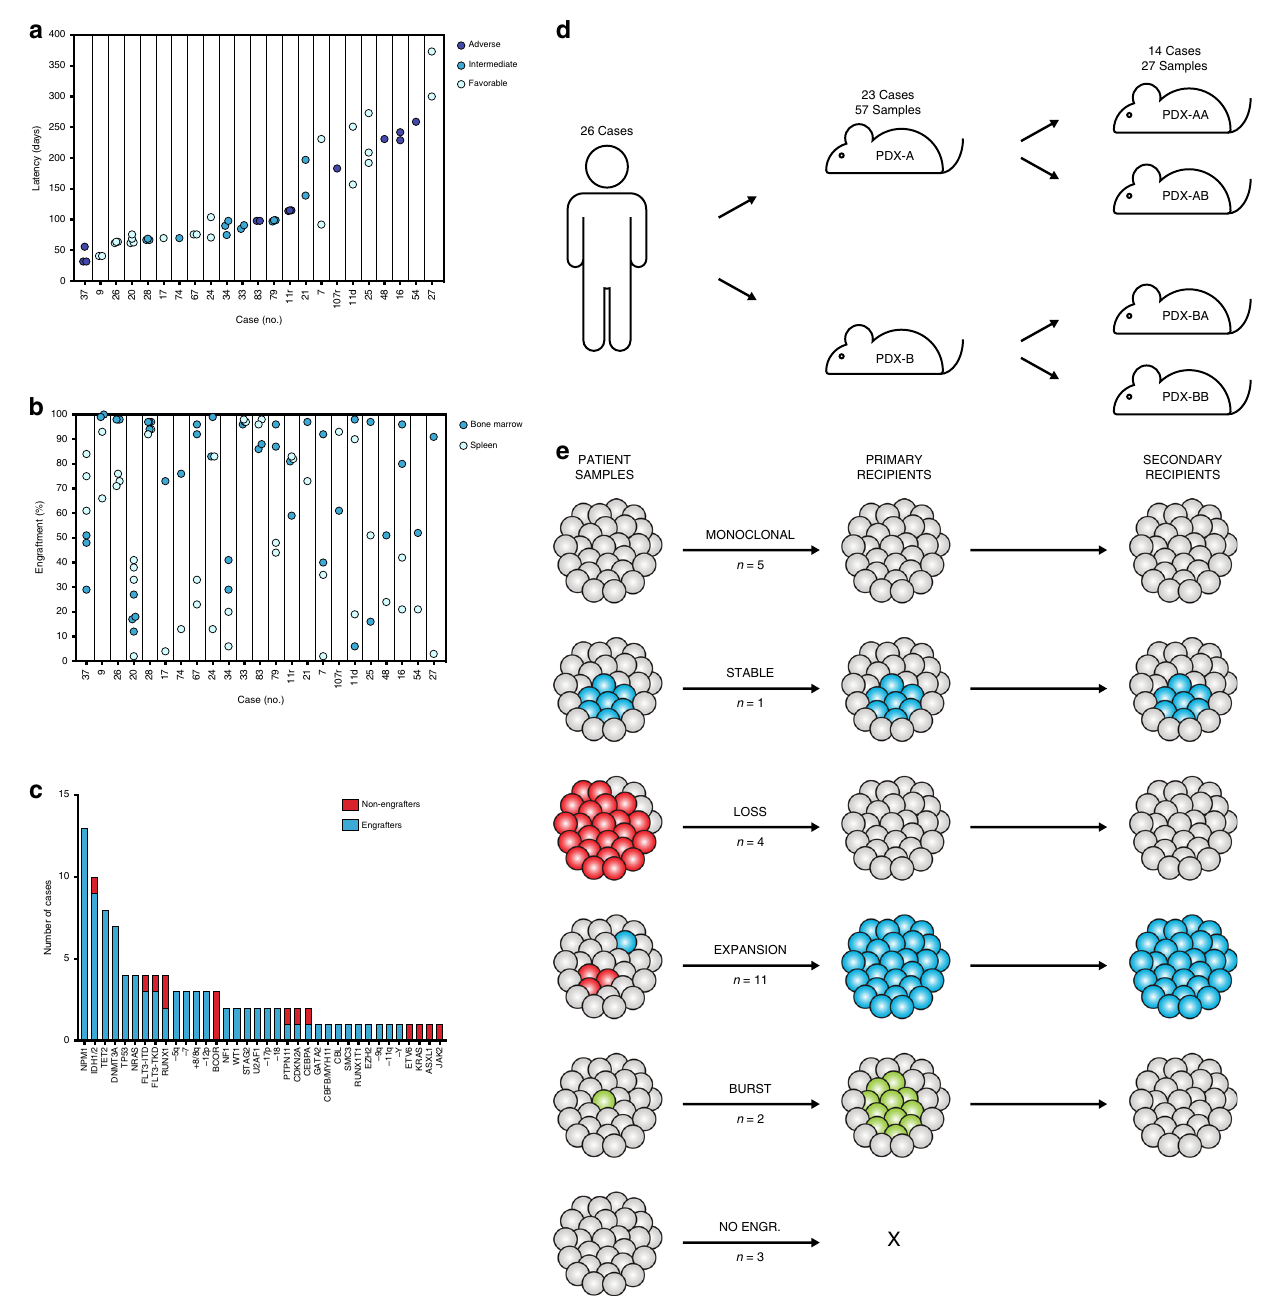
Fig. 1 Patient-derived AML xenografts undergo extensive clonal competition across multiple generations. Latency ( a ) and engraftment levels ( b ) in primary recipient mice, identically ordered by average disease latency. Risk categories were based on the ELN 2017 guidelines. c Engraftment of primary AML samples based on the presence of recurrent AML mutations. d Schematic overview of the generation and nomenclature of PDXs. e Patterns of clonal dynamics identi fi ed as leukemias were transplanted to primary and secondary recipient mice. n denotes the number of cases that follow each